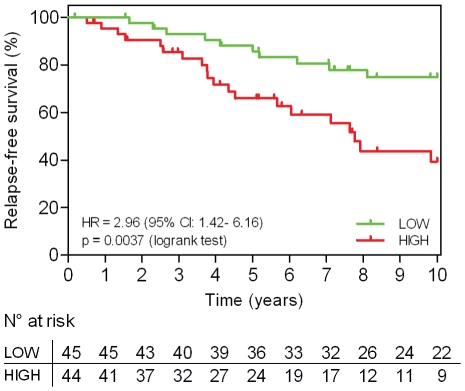
Kaplan-Meier analyses for relapse-free survival according to miR-210 expression levels.Validation ER-positive tamoxifen treated population (N = 89) HR: hazard ratio, CI: confidence intervals.